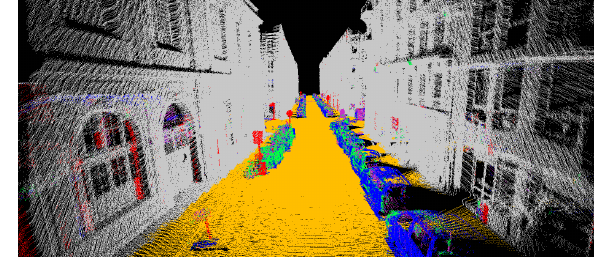
Figure 6: 3D point cloud with semantic labels assigned by the RF classifier (fac¸ade: gray, ground: brown, cars: blue, motorcycles: green, traffic signs: red, pedestrians: